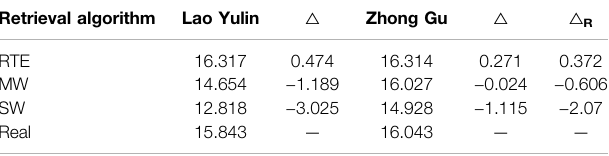
TABLE 3 | Statistics of LST retrieval results (unit: ° C). Retrieval